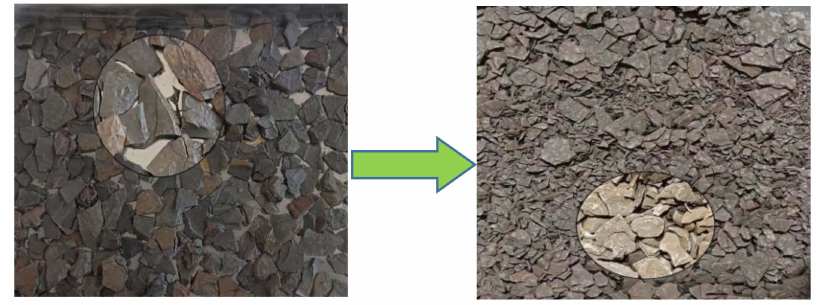
Figure 8. The increasing roundness degree of the